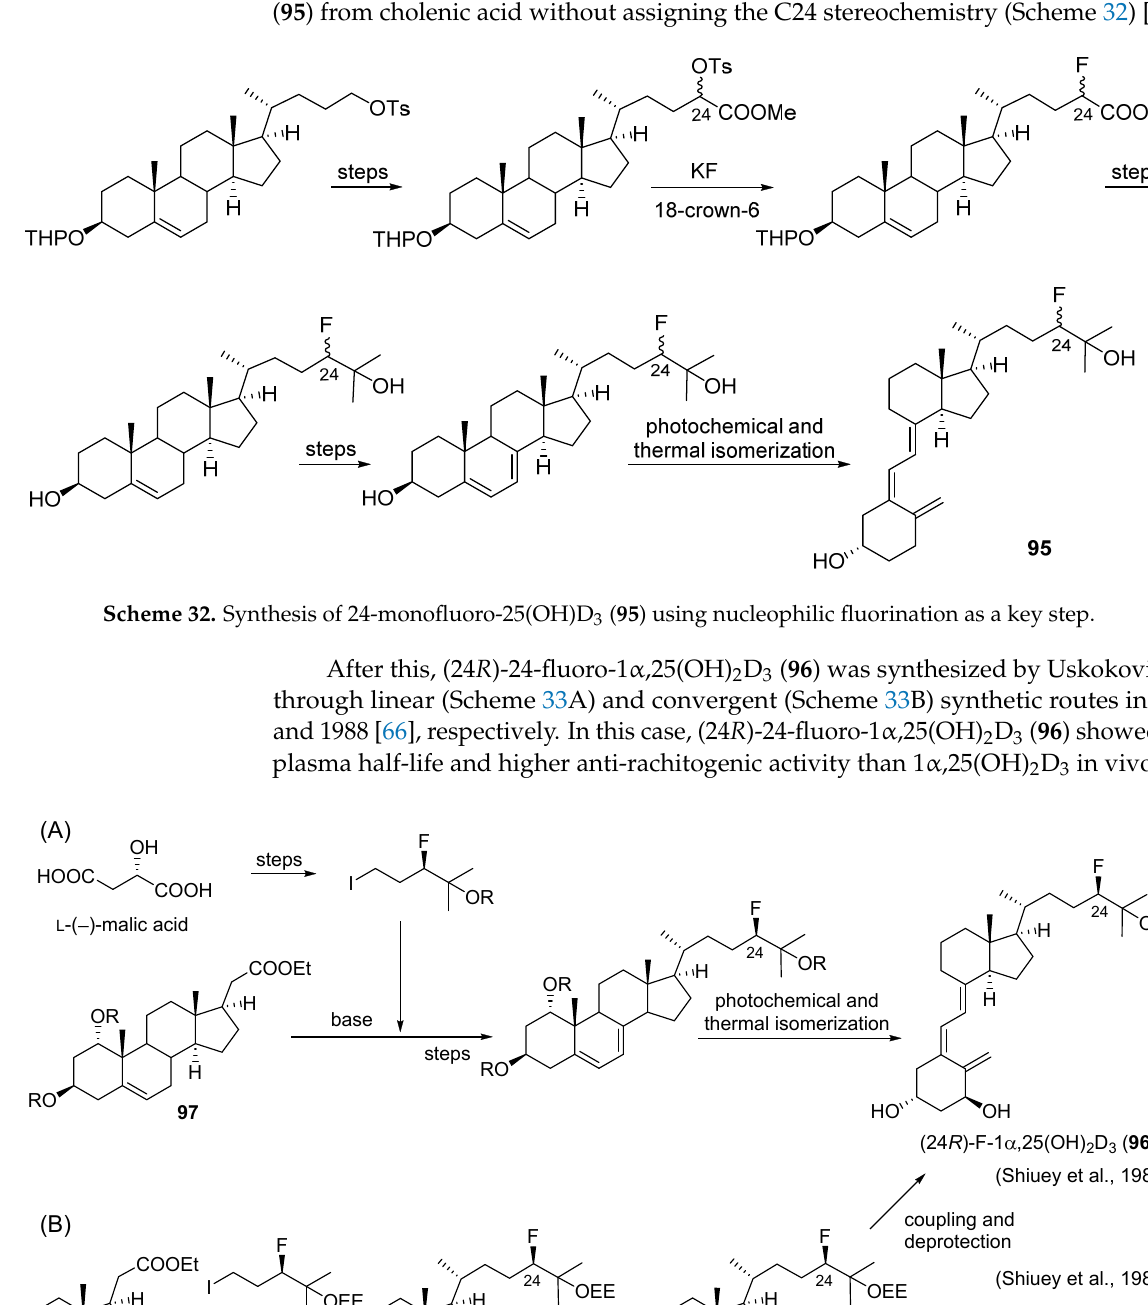
Scheme 31. Efficient construction of the 24,24-difluorinated CD-ring unit ( 94 ) and the subsequent A-ring coupling reaction ( A ). Synthesis of the novel SREBP-specific inhibitor KK-052 ( B ).